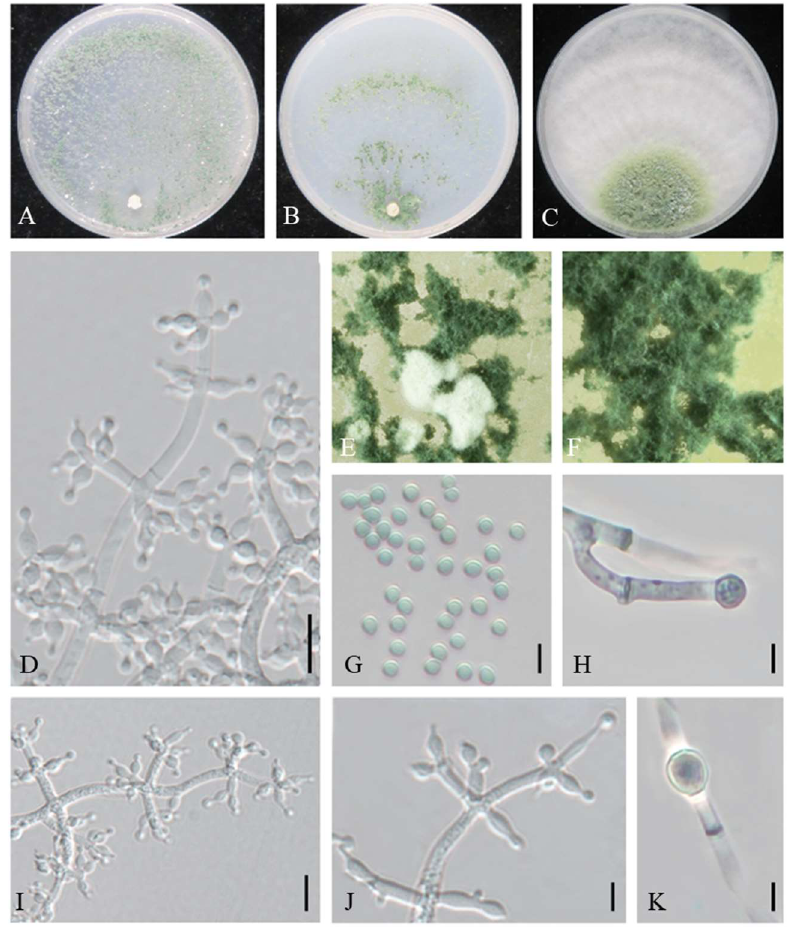
Figure 2. Trichoderma auriculariae (JZBQT1Z7). Cultures at 25 ◦ C after 7 days on ( A ) CMD, ( B ) SNA, and ( C ) PDA; ( D , I , J ) conidiophores and phialides; ( E , F ) conidiation pustules on CMD after 7 days; ( G ) conidia; ( H , K ) chlamydospores. Scale bars: ( D , I ) = 10 µ m, ( G , H , J , K ) = 5 µ m. On PDA after 72 h, colony radius 47–49 mm at 25 ◦ C, 66–68 mm 30 ◦ C, and 5–7